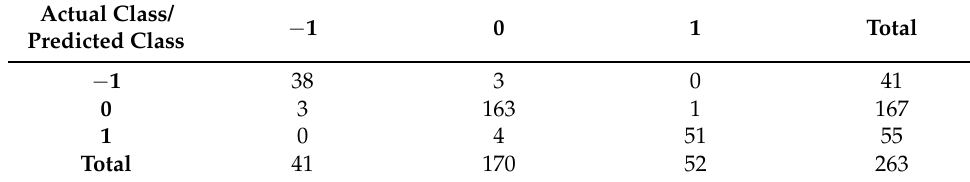
Table 4. Confusion matrix for P22.